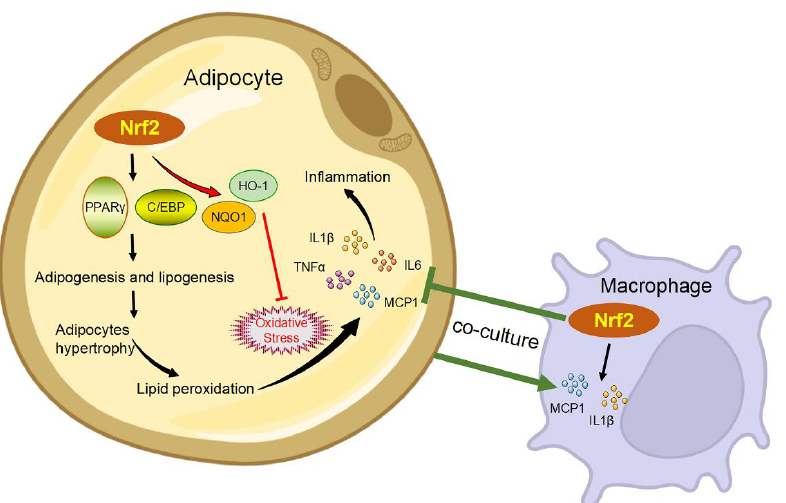
Figure 2. The subtle role of Nrf2 in obesity-related inflammation. Nrf2 promotes adipogenesis and lipogenesis by up-regulating PPAR γ and C/EBP in adipocytes. Thus, continuous activation of Nrf2 under obesity-induced stress conditions may uncontrollably increase lipid accumulation and lead to lipid peroxidation, which in turn causes tissue injury and inflammation. At the same time, Nrf2, as a double-edged sword, counteracts oxidative stress by enhancing the expression of NQO1 and HO-1 and subsequently alleviates inflammation. The mRNA levels of MCP-1 and IL-1 β in macrophages are up-regulated when co-culturing with adipocytes, but this up-regulation is significantly suppressed in Nrf2 KO macrophages. However, co-culturing with Nrf2-deficient macrophages induces the mRNA expression of IL-6 and MCP-1 in adipocytes.